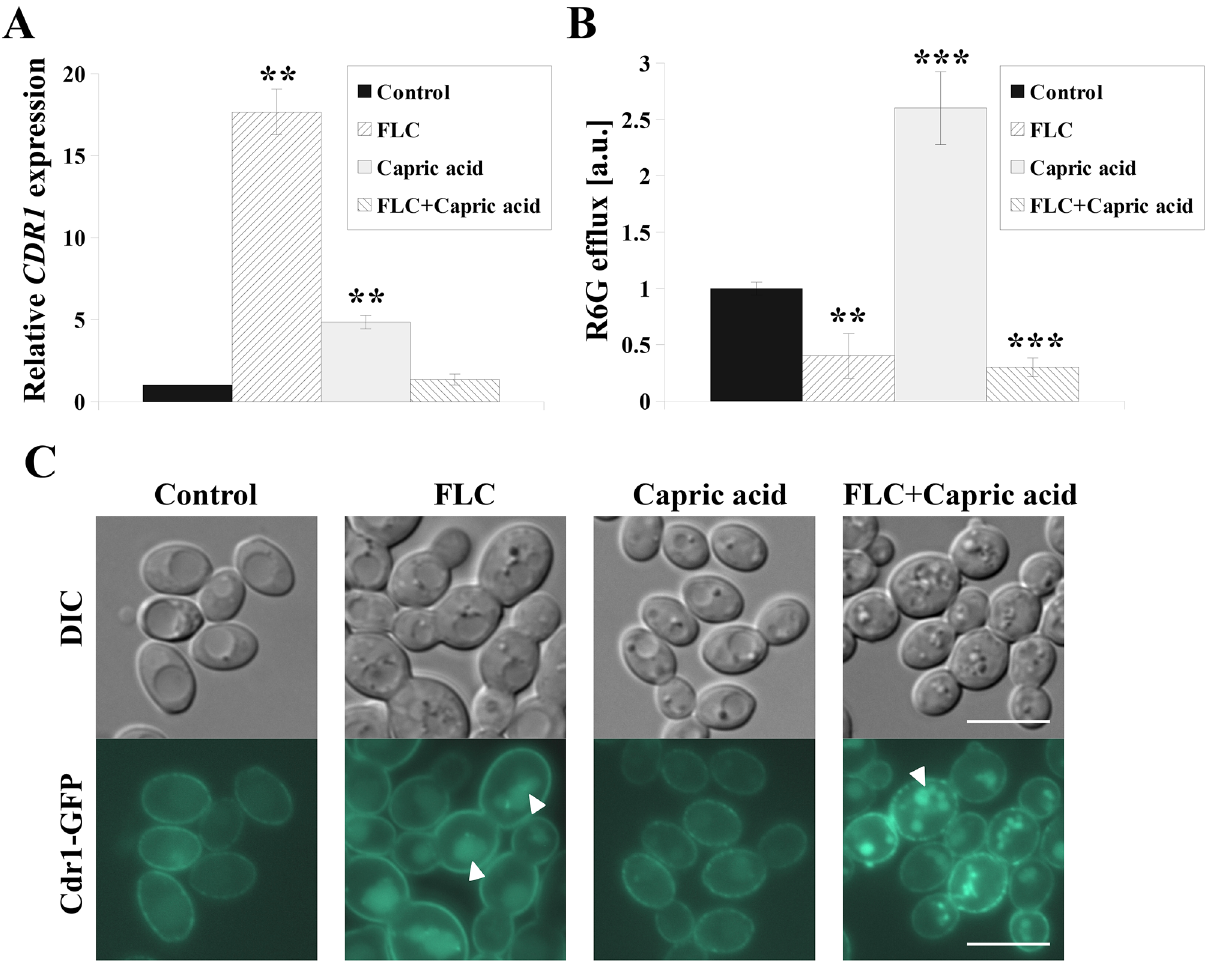
Figure 2. ( A ) Relative CDR1 gene expression in the C. albicans CAF2-1. Gene expression levels are reported as means ± SD of 2 −ΔΔCT values ( n = 3), normalized to 1 for control conditions. ( B ) Cdr1p-dependent rhodamine 6G (R6G efflux) in the C. albicans CAF2-1 normalized to = 1 for untreated control; means ± SD, n = 3. ( C ) Fluorescence micrographs of the subcellular localization of the Cdr1-GFP protein in the C. albicans KS052 (CAF2-1 CDR1-GFP ). For the experiments C. albicans was grown for 8 h in the following conditions: control without antimicrobial agents, FLC—treated with fluconazole 4 μg/mL; Capric acid—treated with capric acid 45.3 μg/mL; FLC + Capric acid—simultaneously treated with fluconazole 4 μg/mL and capric acid 45.3 μg/mL. Statistical analysis was performed by comparing the CDR1 expression level ( A ) or R6G fluorescence intensity ( B ) of cells treated with antimicrobial agent(s) with the corresponding untreated control. Scale bar = 5 μm. Statistical significance was presented as follows: ** p < 0.01; *** p < Activity, localization, and expression of the Cdr1 transporter are altered in C. albicans treated with the capric acid or fluconazole–capric acid combination. Expression and activation of MDR transporters is the first line defense of C. albicans towards azole drugs 25 . Cdr1p belongs to the ATP-binding cas- sette family and is the most influential of the identified MDR transporters involved in FLC efflux in C. albicans 26 . The FLC–capric acid combination lead to greater growth inhibition in C. albicans than treatment with FLC alone (Fig. 1). Thus, we aimed to investigate the relative effect of capric acid and FLC-capric acid combination on the expression and activity of CDR1 , as well as on the localization of Cdr1p (Fig. 2). FLC alone induced increased CDR1 expression almost 18-fold and capric acid alone almost fivefold compared with untreated C. albicans cells (Fig. 2A). However, an only 1.3-fold increase in CDR1 expression was identified after treating C. albicans with combination of both compounds.